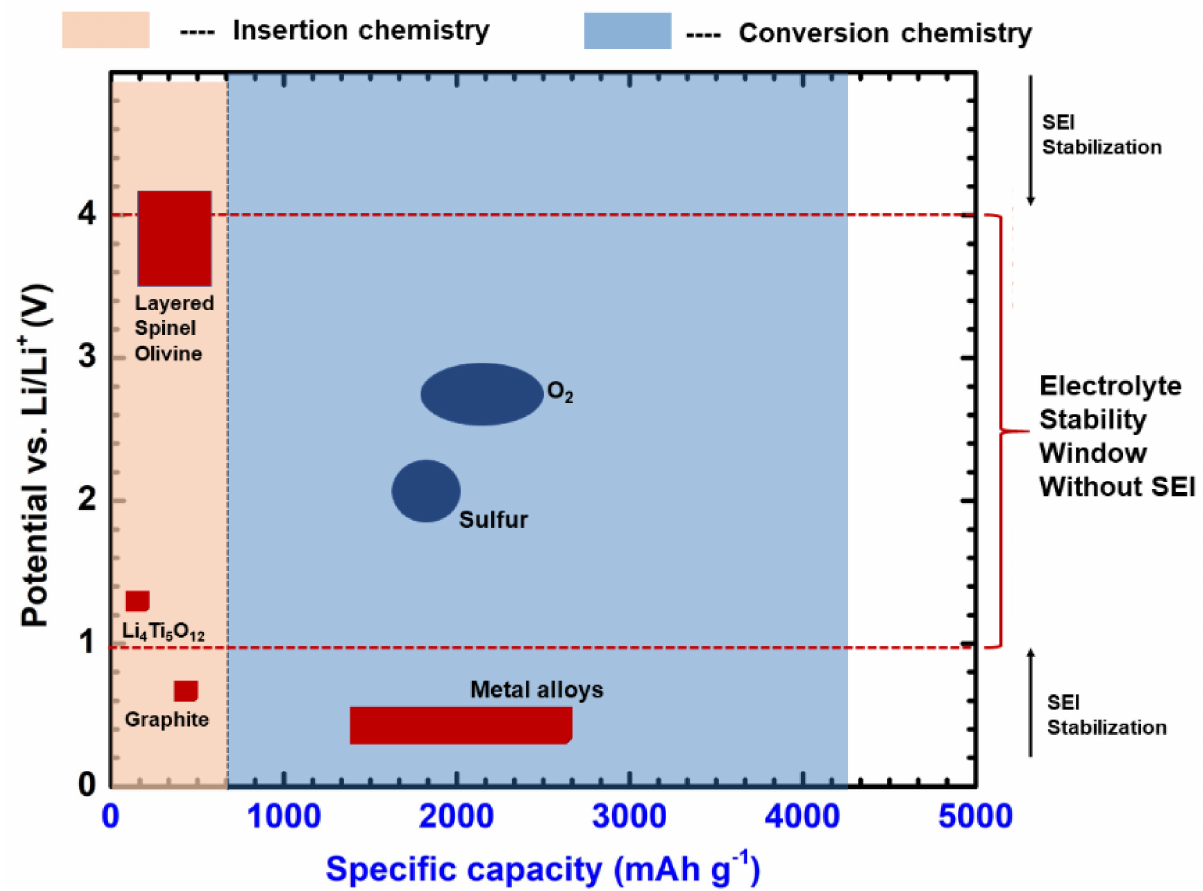
Figure 18. Specific capacity and SEI stability of Li